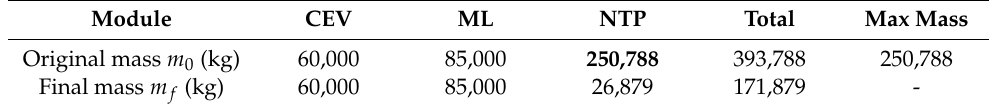
Table 13. Mass scale of Architecture-5.